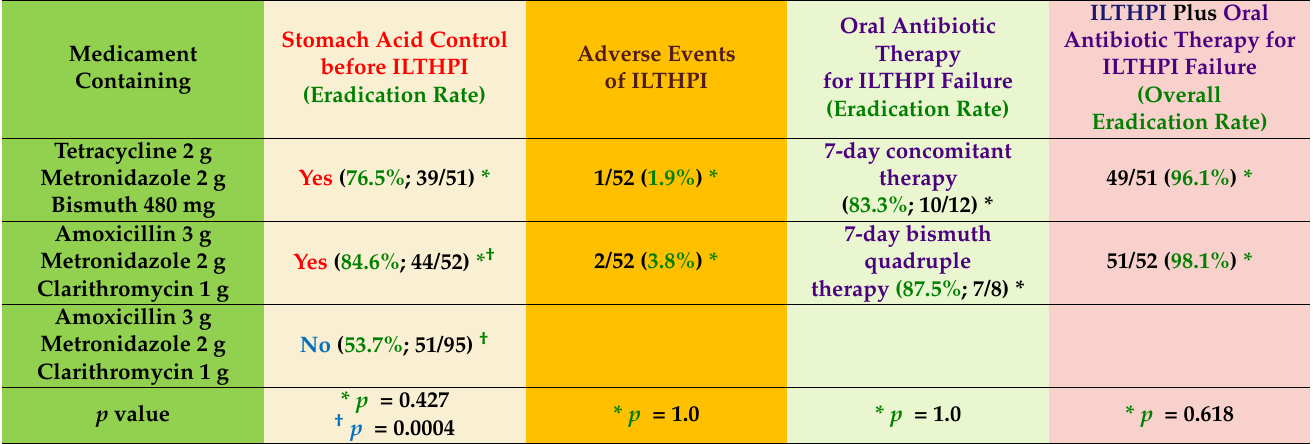
Table 6. Comparison of medicament containing Tetracycline, Metronidazole, and Bismuth versus Amoxicillin, Metronidazole, and Clarithromycin for